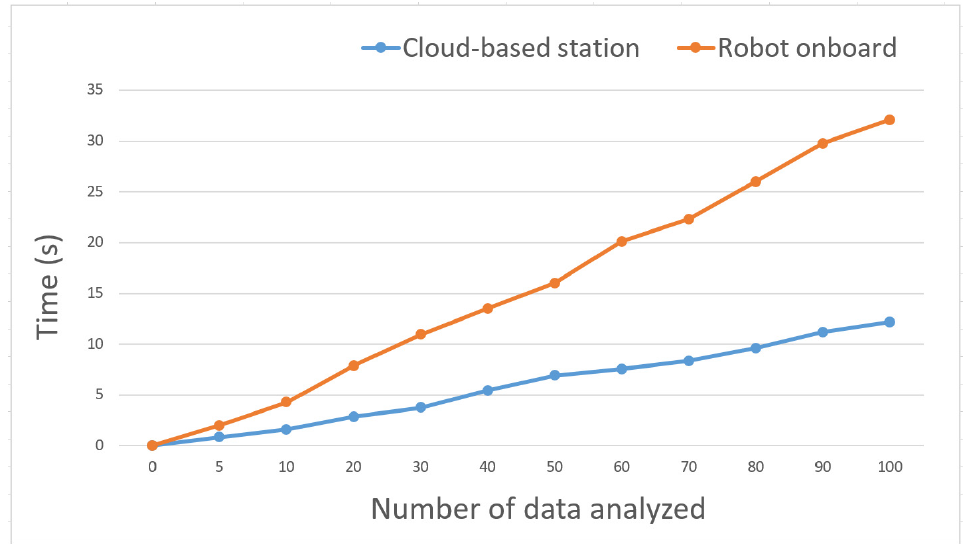
Figure 17. Computational power analysis between individual robot node and cloud-based station.